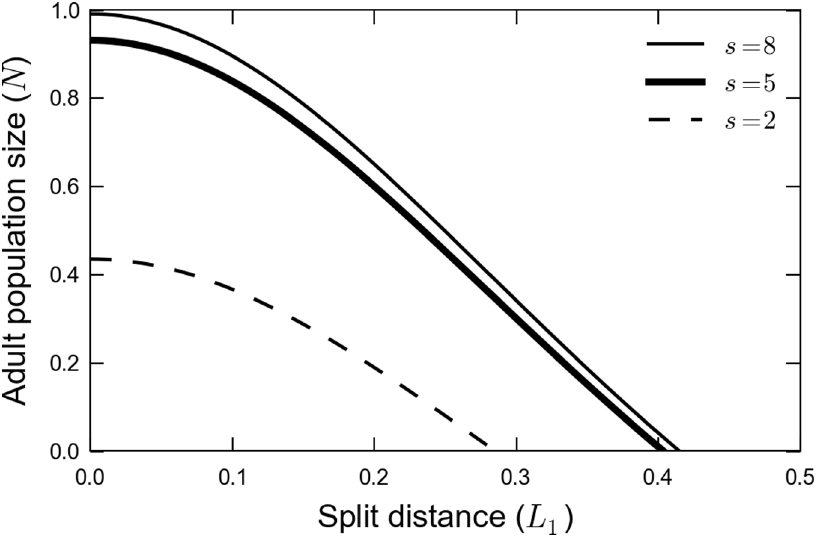
Figure 5. Curve of adult population size versus split distance. In this figure we point the effect of the size of the fragment on the critical split distance. This figures show that large forest fragments have only a limited effect to reduce the habitat split local extinction prevision. The parameters used r ~ K ~ m J ~ D J ~ D A ~ L 1 ~ b ~ 1 and m A ~ 0 : 01 .